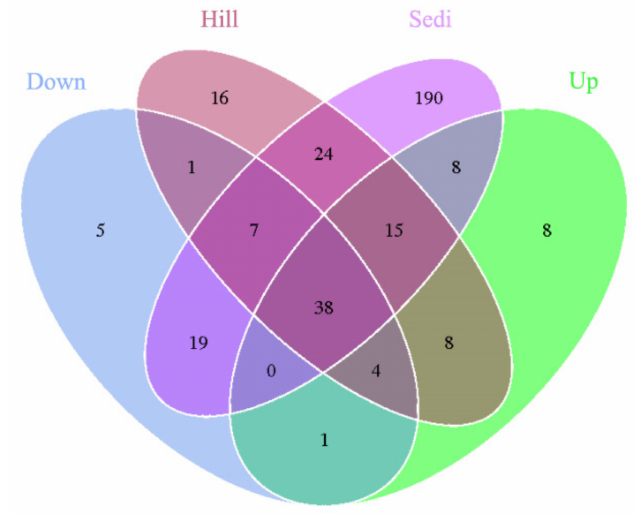
Figure 3. A Venn diagram displaying the degree of overlap of the archaea OTUs (at a 3% evolutionary distance) among the four sampling